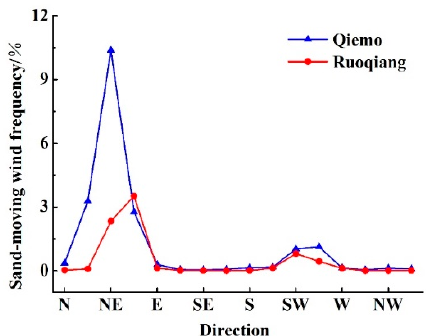
Figure 3. Annual sand-moving wind frequencies in various directions.